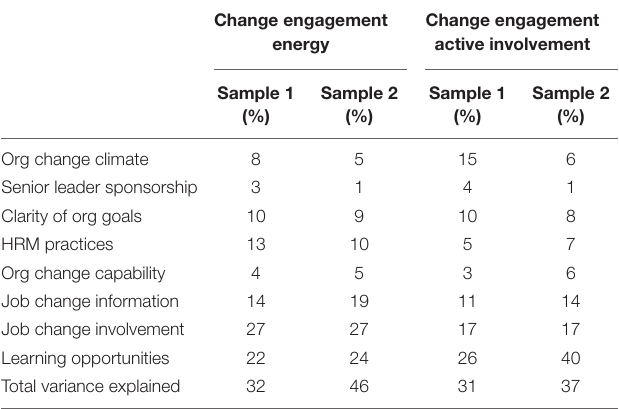
TABLE 3 | Relative weights analyses showing percent of variance explained in change engagement energy and change engagement active involvement in Sample 1 and Sample